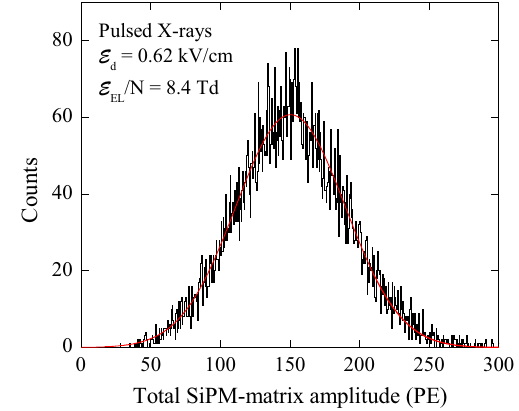
Fig. 21 Direct SiPM-matrix readout: amplitude spectrum of the total SiPM-matrix signal obtained with pulsed X-rays and 2 mm collima- tor. Red curve is fit by Gauss function. The data were obtained at the maximum reduced EL field, of 8.4